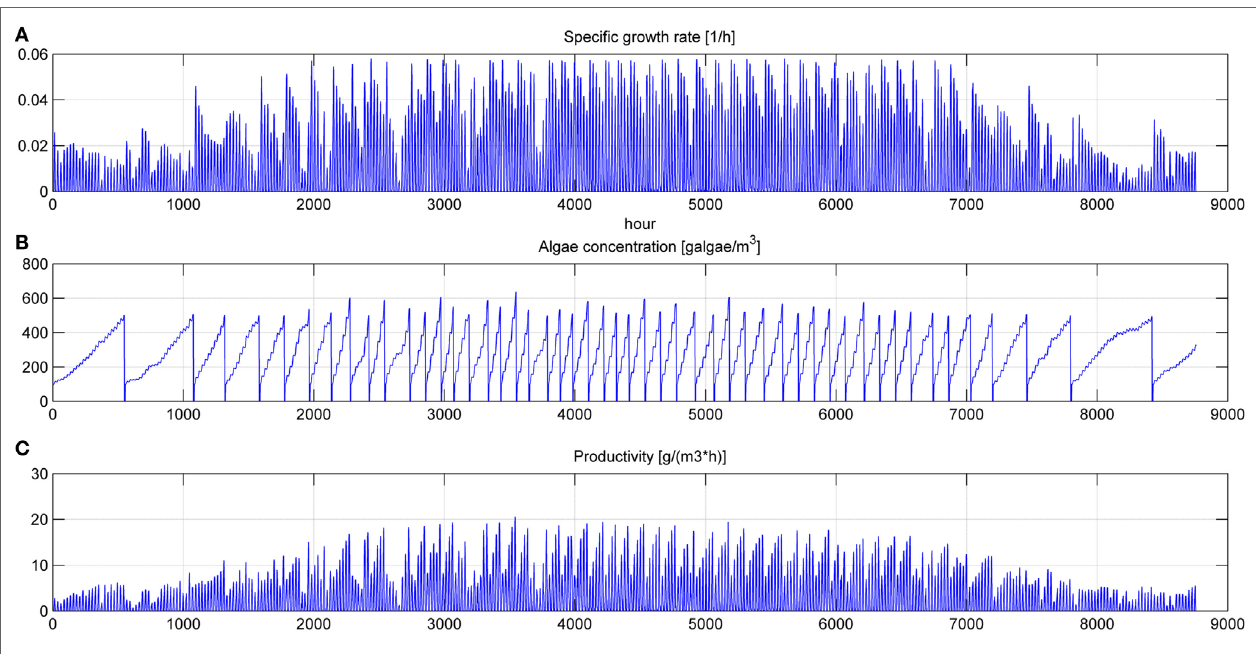
FigUre 9 | specific growth rate (a), microalgae concentration in the pond (B) and microalgae growth rate (c) for a simulation time equal to 1 year